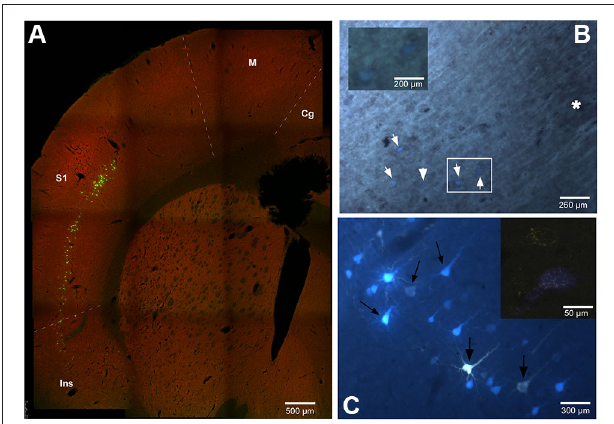
FIGURE 2 | (A) Confocal microscope microphotograph of a coronal section of the brain in animal RE9 at Bregma 2.16 mm stereotaxic coordinates, showing double labeled neurons in S1 and Ins cortices. (B) Microphotograph showing the barrel zone of S1 cortex in animal RE8 where the fluorescence was combined with cytochrome oxidase technique. Asterisk corresponds to the barrel zone, white arrows points the retrograde labeled neurons. Cytochrome oxidase labeled neurons located in the white square, are magnificated in the inset. (C) Microphotograph of S1 cortex in animal RE9 showing the FlGo and FB labeled neurons. Black arrow shows the double labeled neurons. Inset: Confocal microscope detail of a single FlGo labeled neuron (up) and double labeled neuron (down). Calibration toolbar: A: 500 µ m, B: 260 µ m, inset 200 µ m C: 300 µ m, inset 50 µ